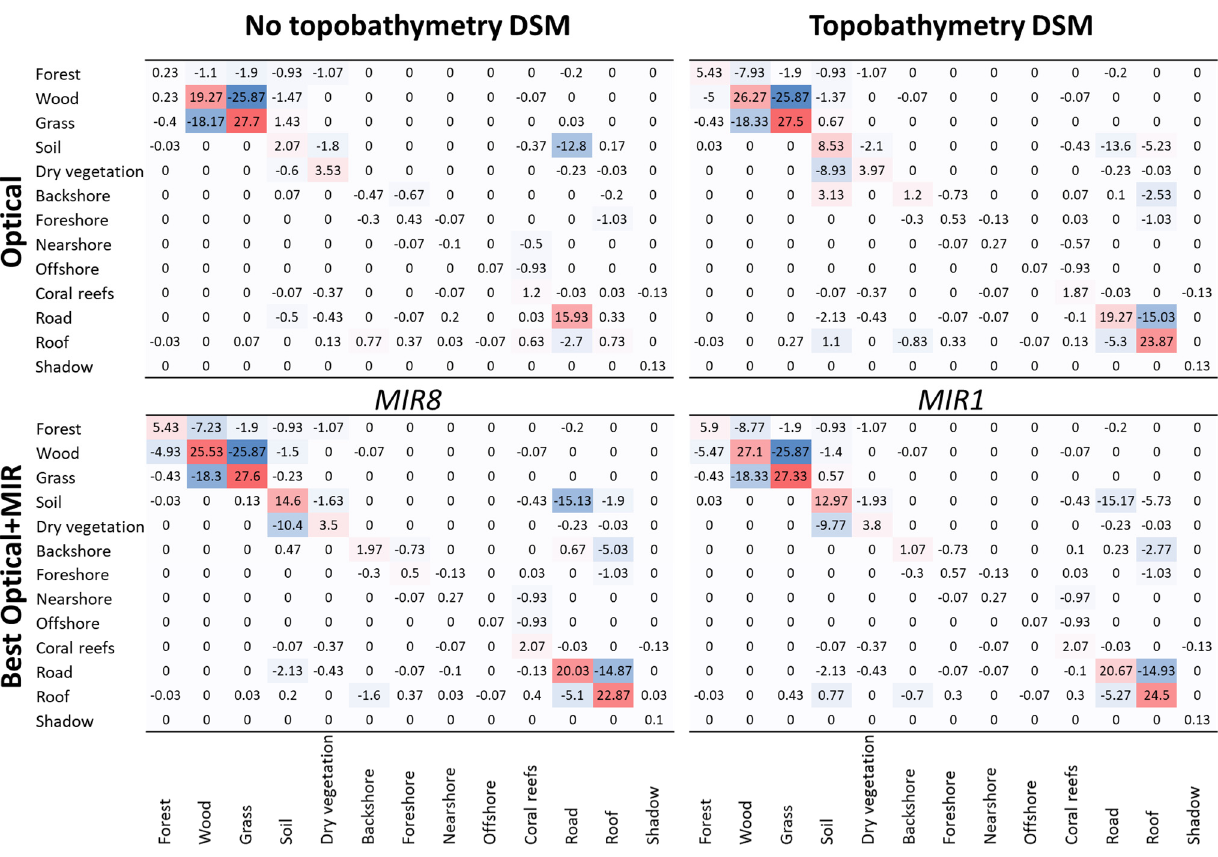
Figure 9. Confusion matrices of the percent differences between the WorldView-3 basic blue-green-red classification validation and the best results for multispectral and superspectral combinations, deprived of and provided with WorldView- 3 topobathymetric DSM.